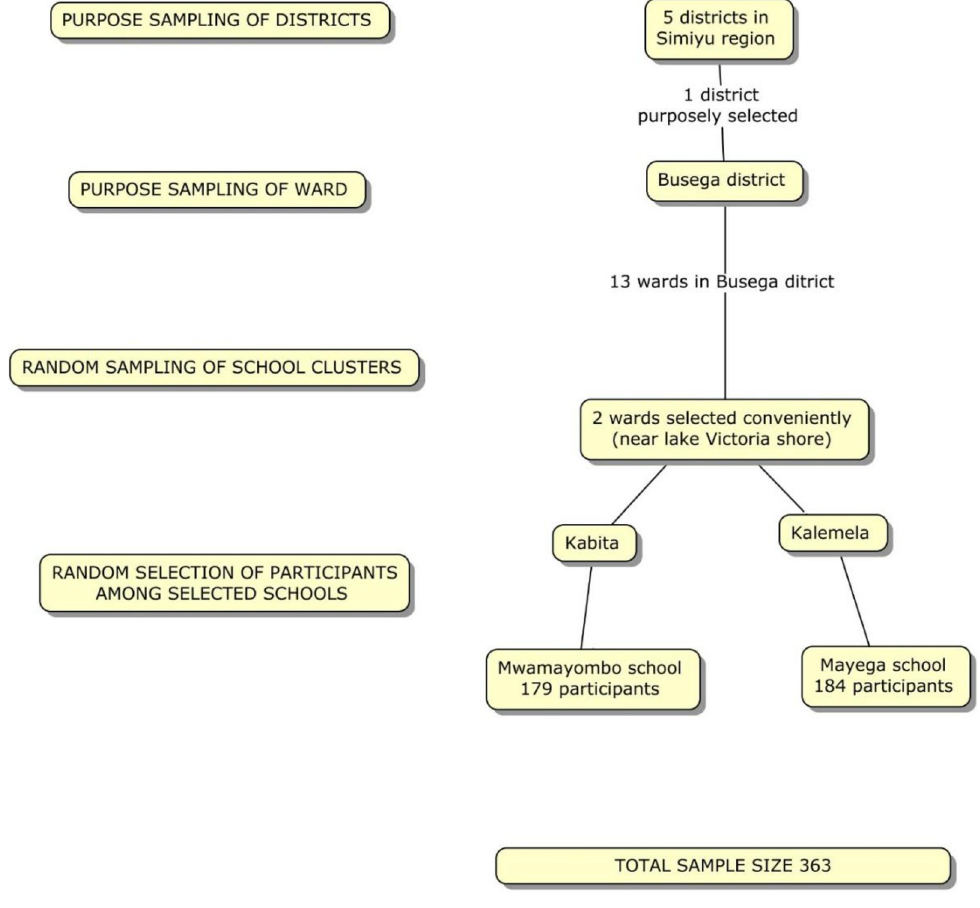
Fig 1. Flow chart of sampling